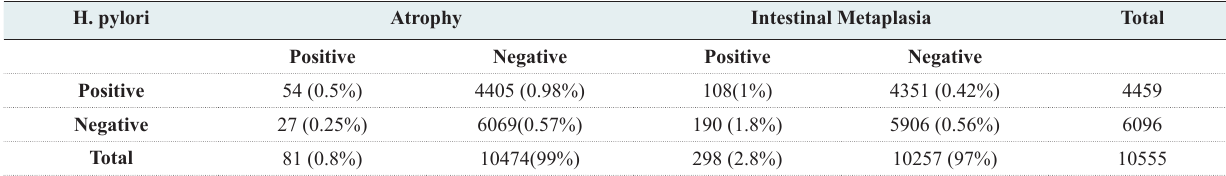
Table 2: Distribution of Atrophy and intestinal metaplasia in relation to H.pylori infection.